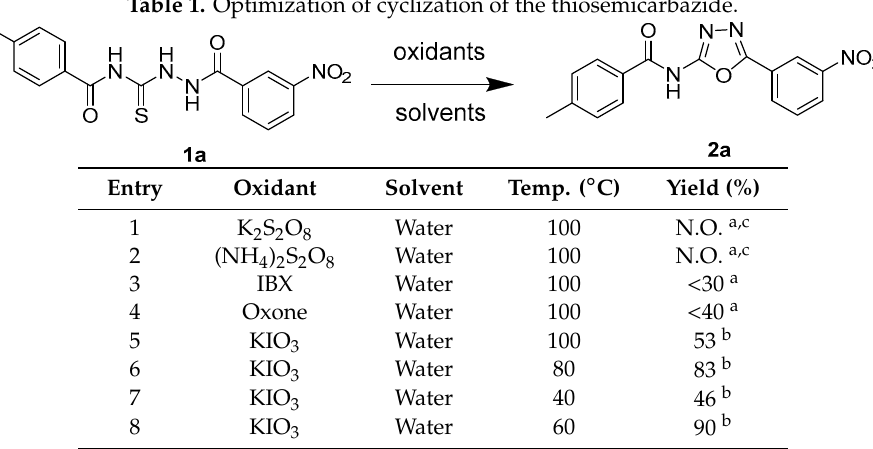
Table 1. Optimization of cyclization of the thiosemicarbazide.